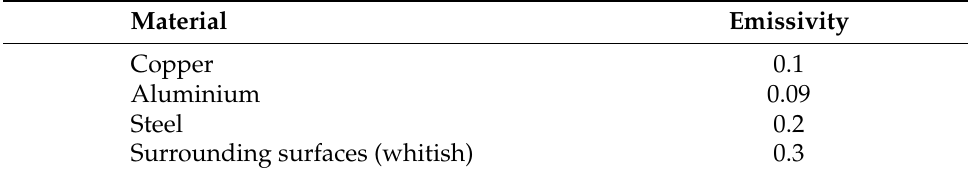
Table 3. Emissivity of materials in the